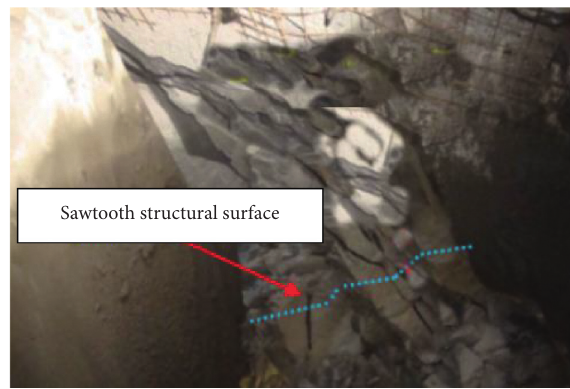
Figure 2: Sawtooth structural plane in a pit created by rockburst damage